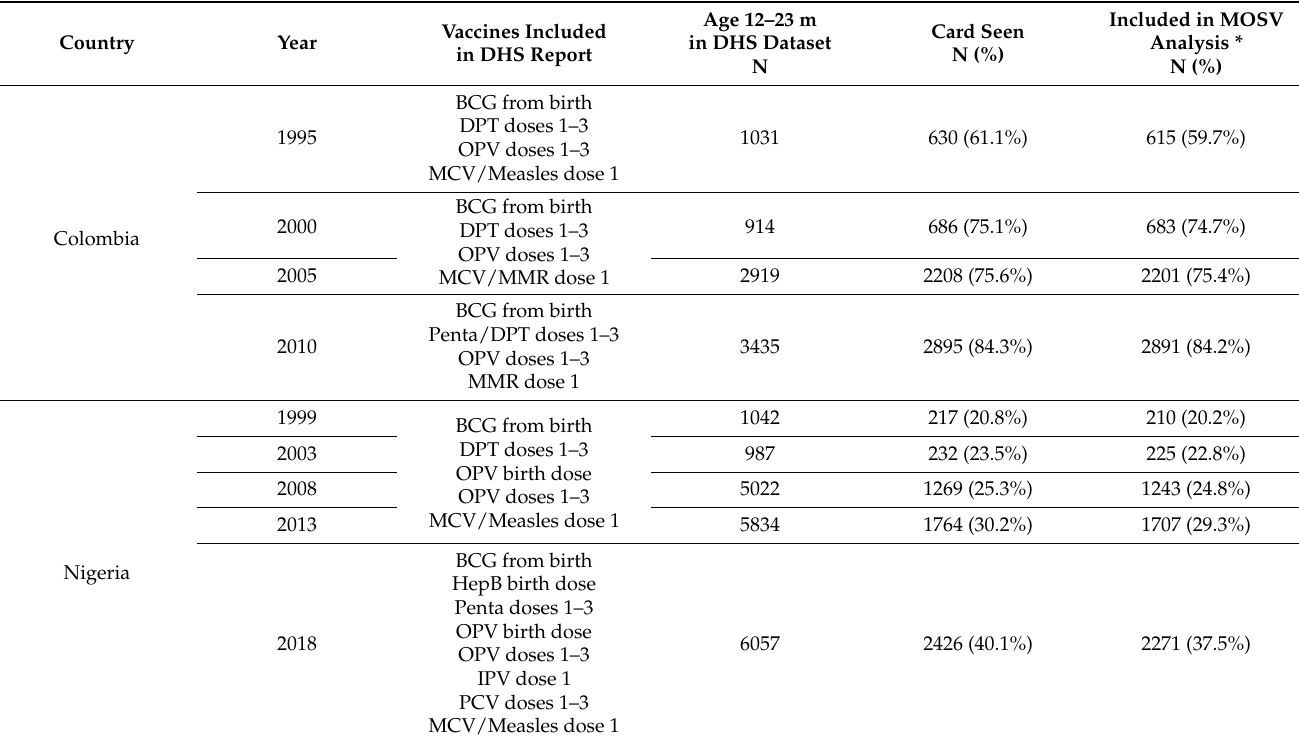
Table 1. Surveys and doses and children available for